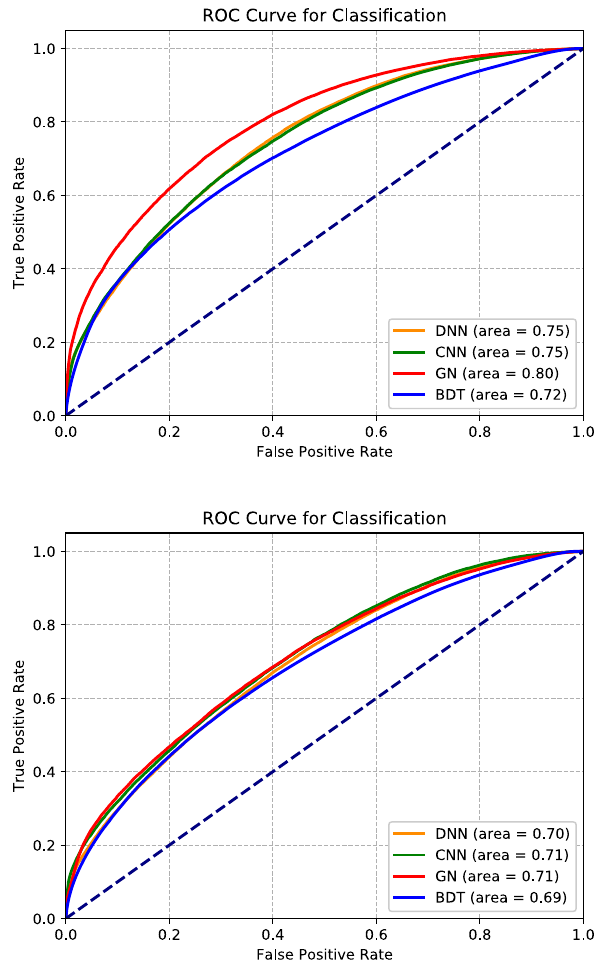
Fig. 17 ROC curve comparisons for variable-angle γ / π 0 classifica- tion on data resampled to ATLAS-like (top) and CMS-like (bottom) geometries. Algorithms compared are DNN, CNN, GoogLeNet (GN), and